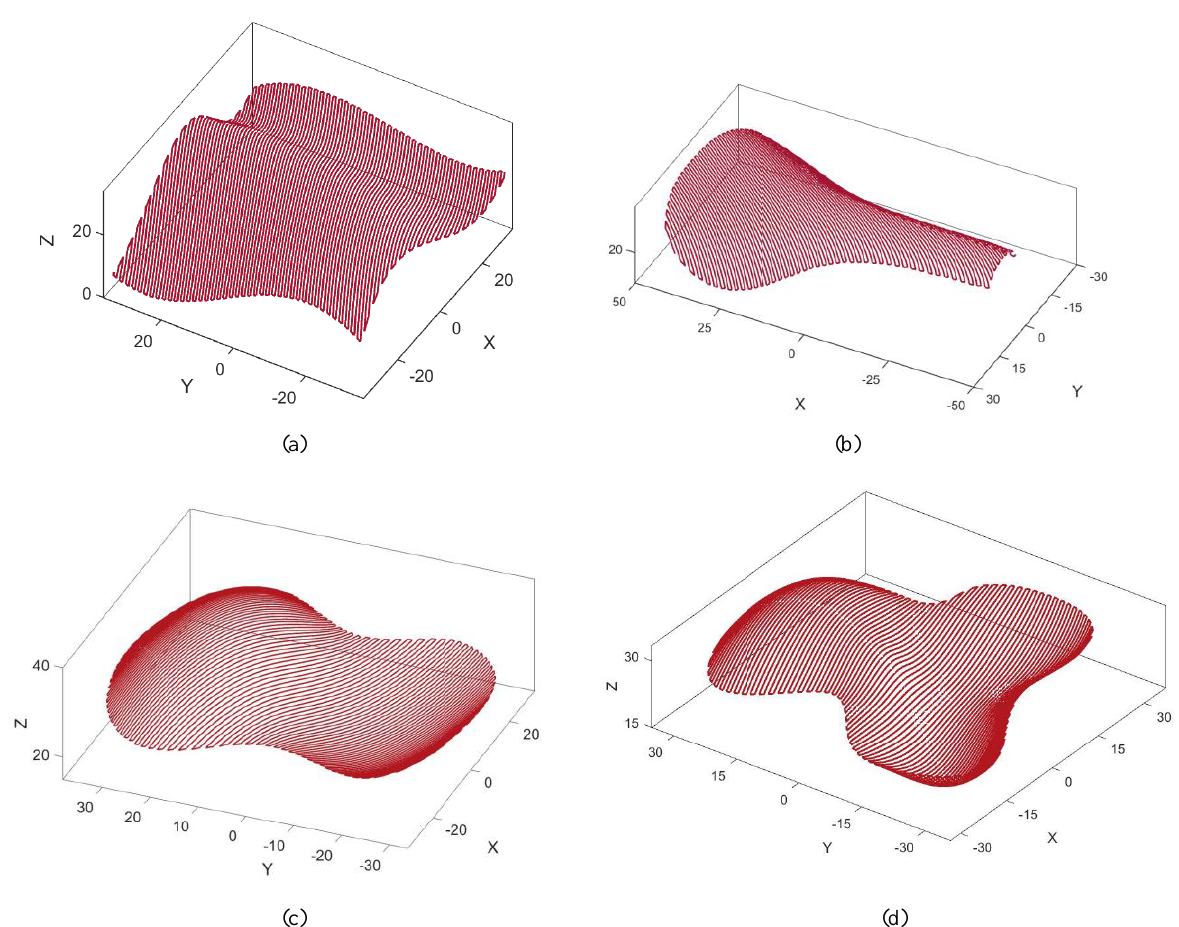
Figure 10. Printing NL curves in the zig-zag pattern for: ( a ) Saddle surface 𝑆 1 , ( b ) Bicycle seat surface 𝑆 2 , ( c ) Freeform surface-1 𝑆 3 , and ( d ) Freeform surface-2 𝑆 4 .